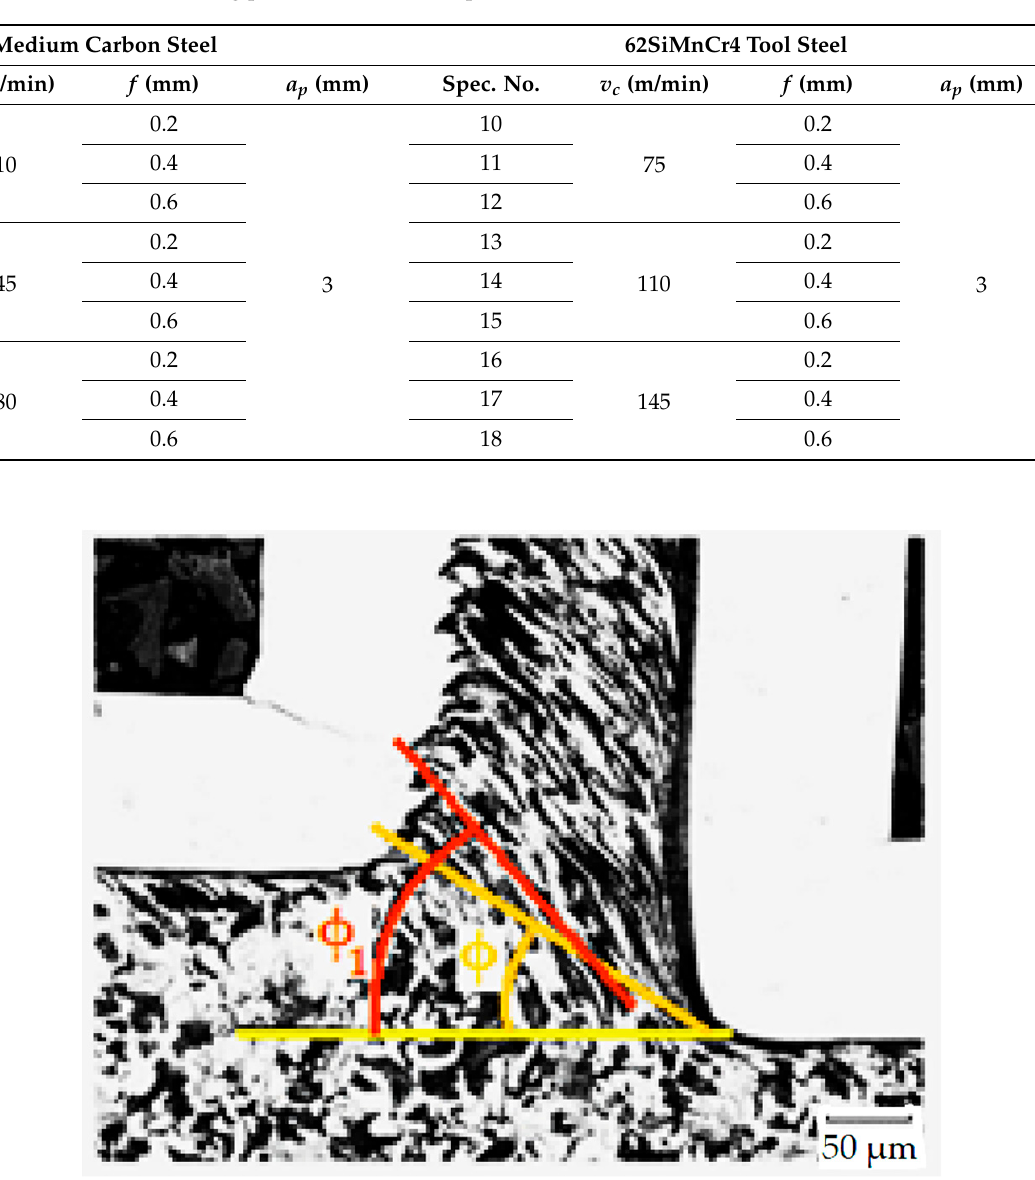
Table 3. Cutting parameters used in experiment.